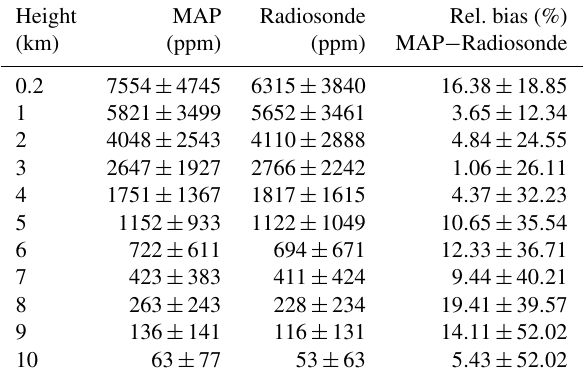
Table 2. Yearly mean and standard deviation for a priori MAP and radiosonde profiles at each level in 2018 and for their corresponding relative